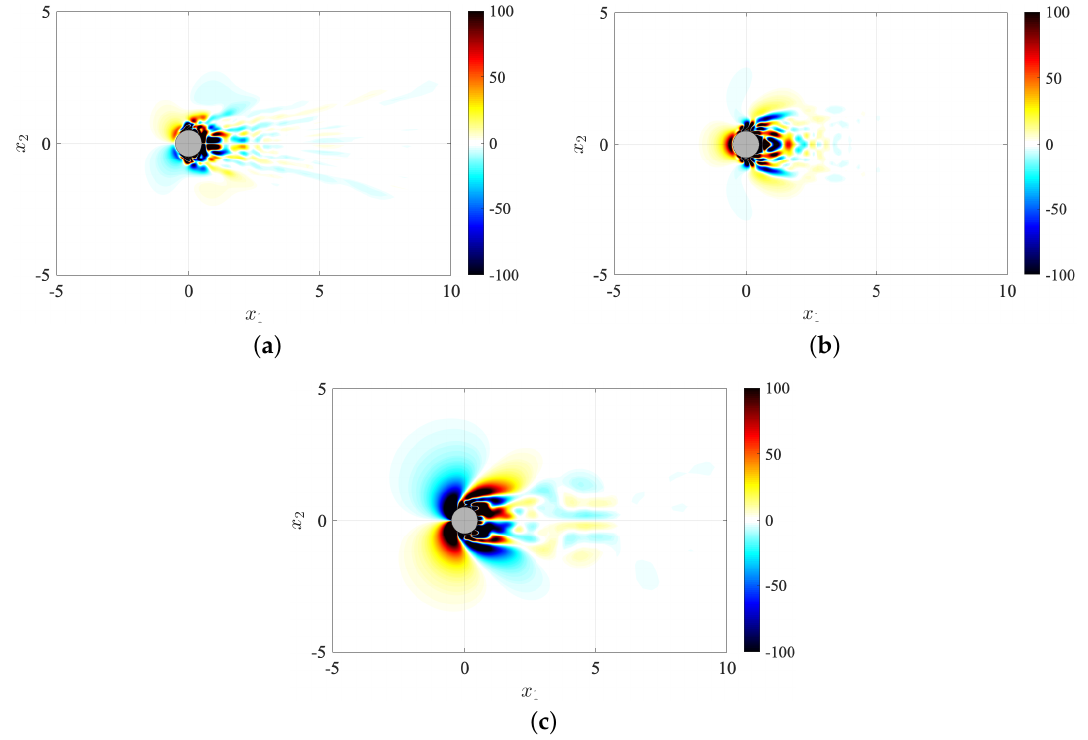
Figure 10. Gain of the control law (SF-2) for ( a ) u 1 , ( b ) u 2 , and ( c ) p .